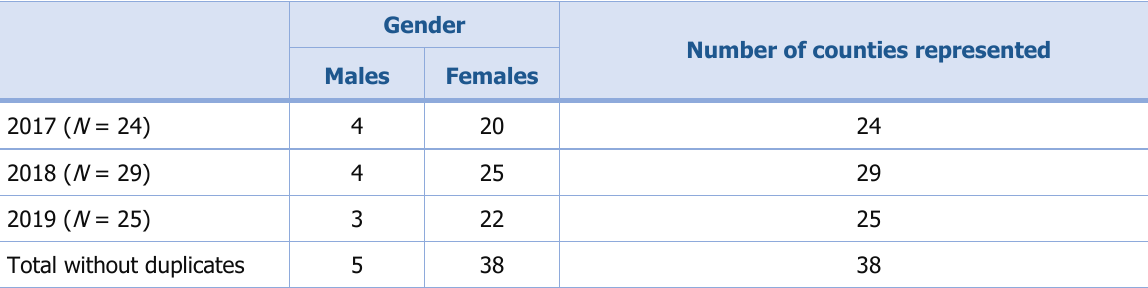
Table 4. 4-H Professional